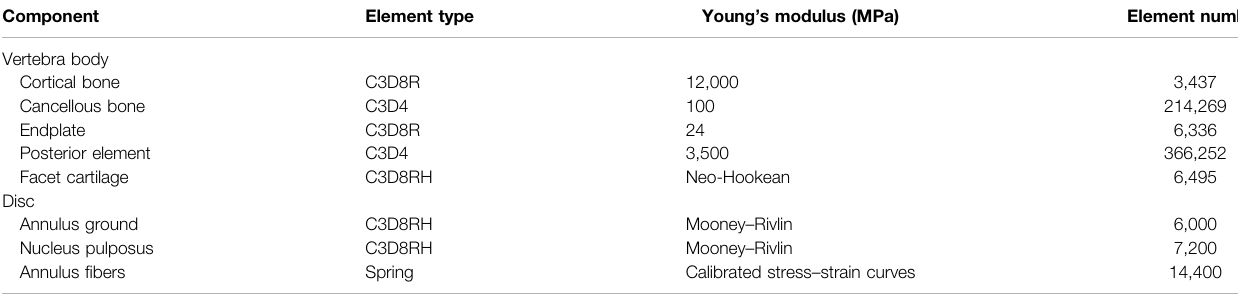
TABLE 1 | Element type and number of the components in the intact model.